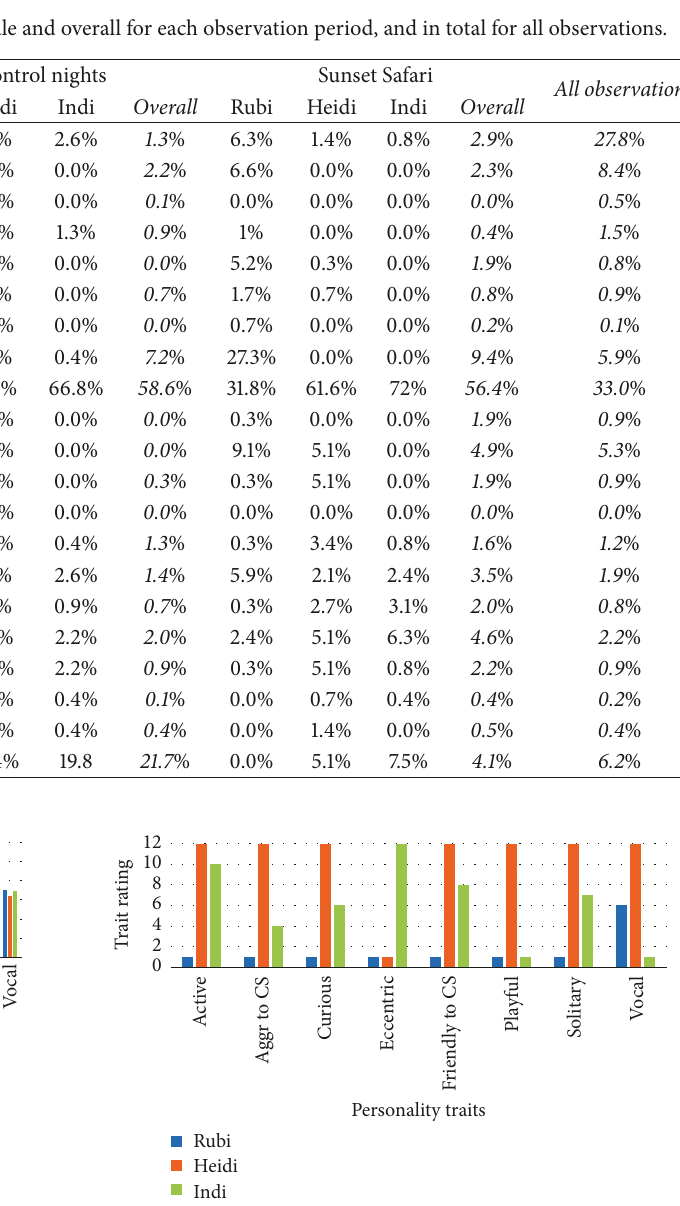
Figure 10: Personality profiles for each female compiled from observation data. Aggr = Aggressive, CS =